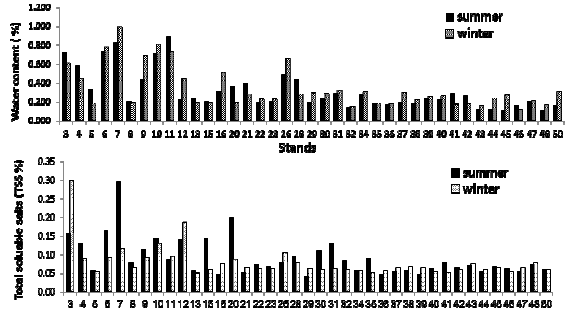
Fig. 1. Water content (%) and total soluble salts (TSS %) in soil samples of the studied stands inhabited by L. pyrotechnia and Z. spinosa in Wadi El-Assiuty during summer and winter